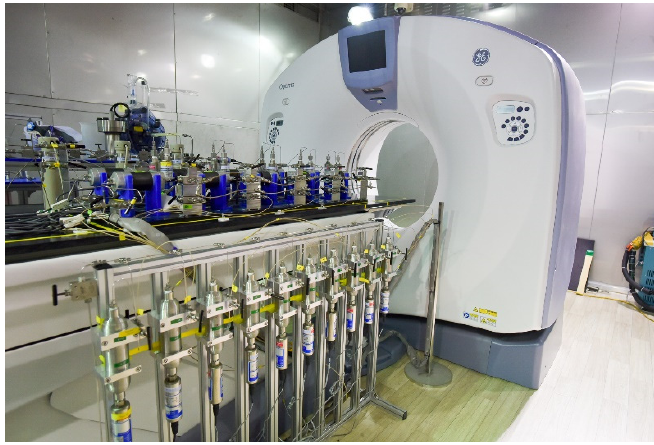
Figure 1. A schematic diagram of the GH visualization system at KIGAM [6,8].